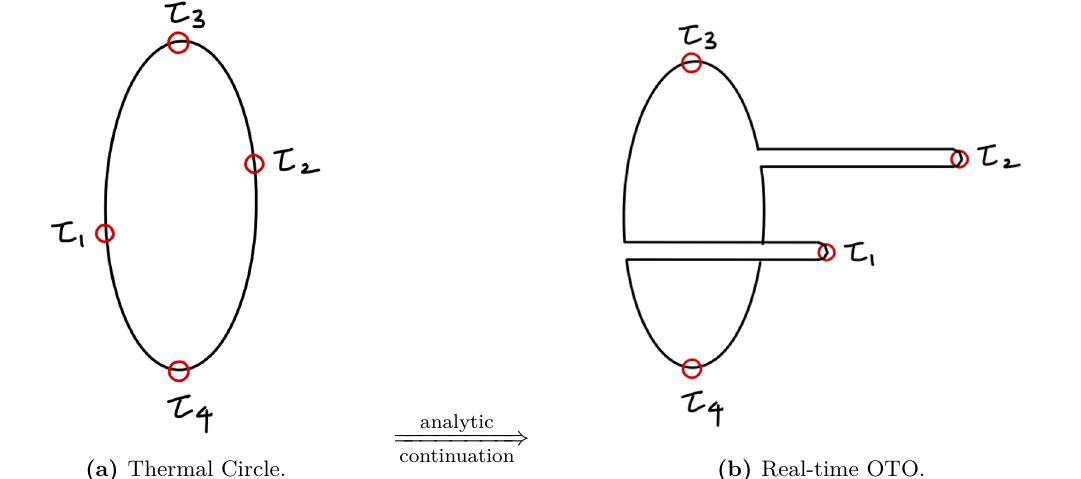
Figure 1 . We evaluate the Euclidean four point function for the configuration in (3.5). Then, we analytic-continue it to real-time OTOC by